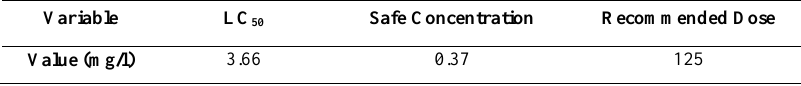
Table 1. LC50 and safe concentration for Parastar 40 WP